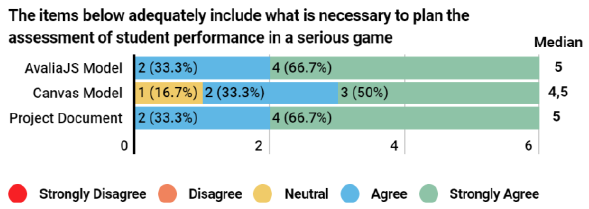
Figure 8. Experts’ answers regarding the adequacy (item 6) of the AvaliaJS model .